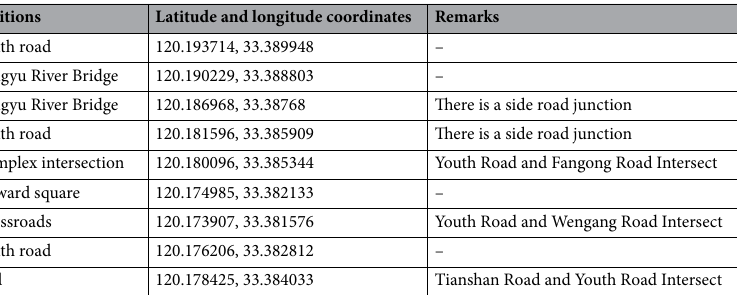
Table 11. The table mainly includes location, longitude and latitude coordinates and remarks. The location is divided into Youth road and Tongyu River Bridge. The longitude and latitude coordinates are consistent with the location.